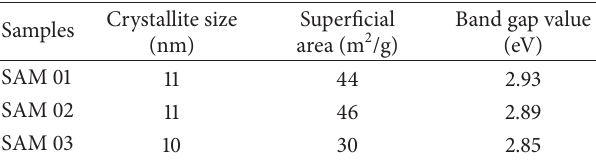
Figure 3: FTIR spectra of SAM 01, SAM 02, and SAM 03 samples. Table 1: Crystallite size, superficial area, and band gap values of :N TiO 2